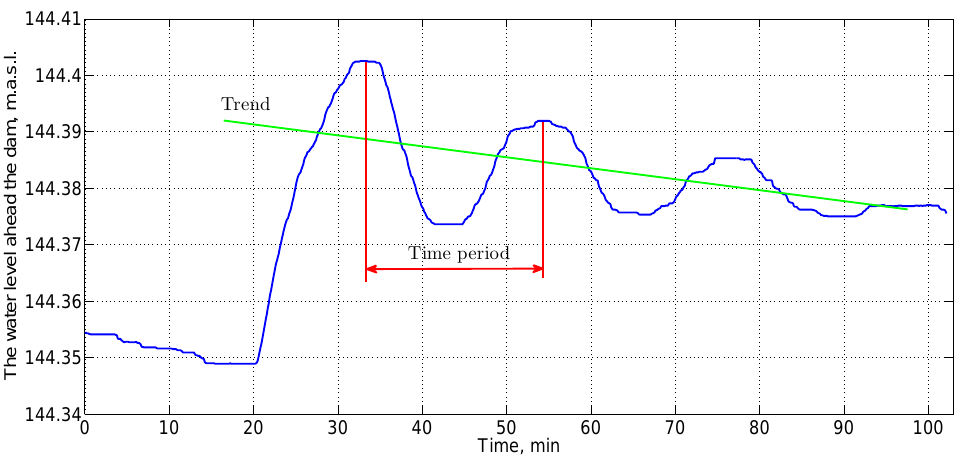
Figure 11: Plot of experimental result of the water level ahead of the Grønvollfoss dam.